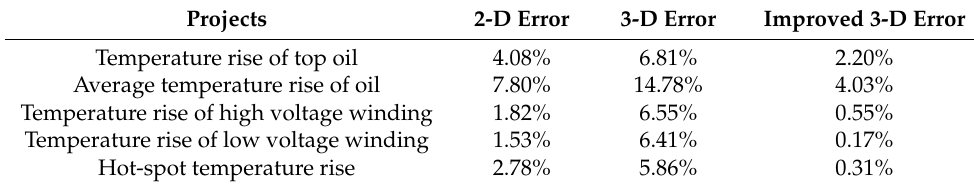
Table 4. The relative error of temperature rise